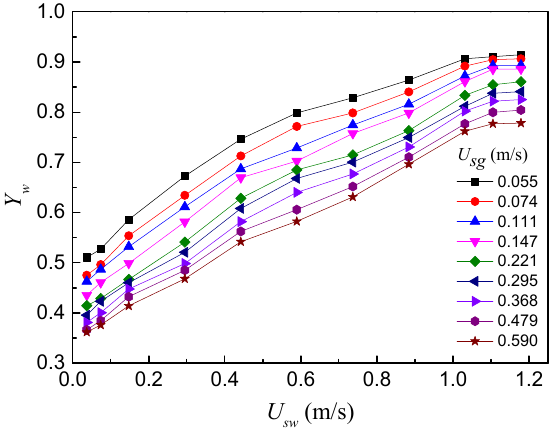
Figure 6. Water holdup measurement results of the REFCS.